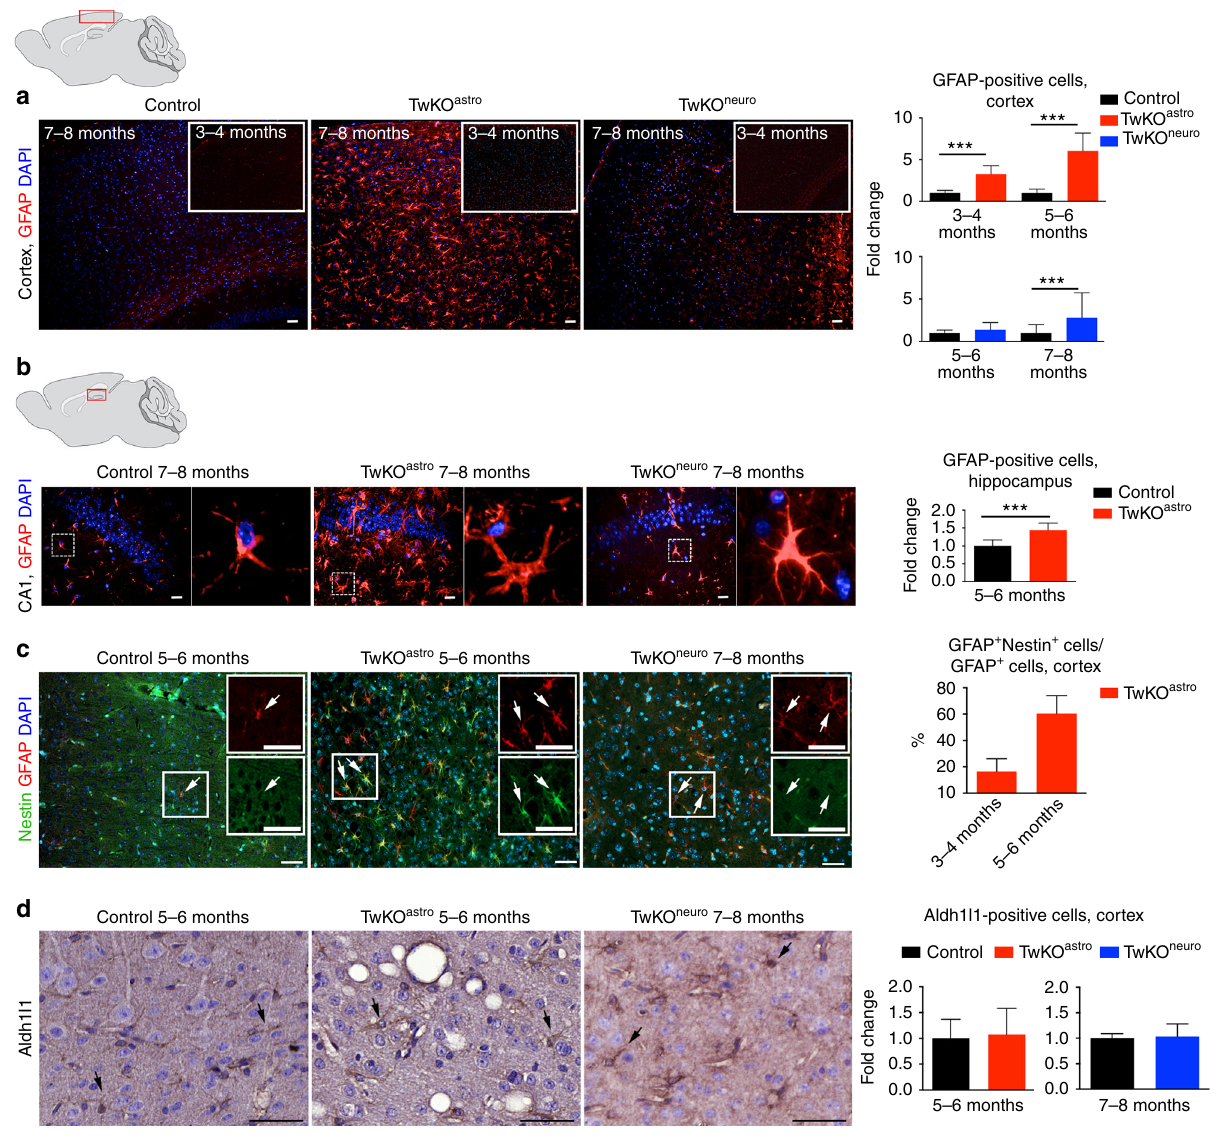
Fig. 3 MtDNA loss in astrocytes causes massive astrocyte activation. a , b Astrocytes (GFAP, red) in somatosensory cortex ( a ) and in hippocampus, CA1 area ( b ) of 7 – 8-month-old mice and 3 – 4 months as shown in inset of ( a ). In b , boxed area is enlarged on right. c Astrocytes (GFAP, red) immuno-co- stained with reactive astrocyte marker (Nestin, green). Insets enlarge the boxed area. Arrows show the same cells. d Astrocytic marker Aldh1l1 immunohistochemistry, counterstaining hematoxylin. TwKO astro show intensive vacuolization. Brain graphs show sampling site. Fluorescence fi gures are counterstained with DAPI (blue). Bar graphs on right hand side: corresponding quanti fi cations of GFAP + cells (cortex and hippocampus); GFAP + Nestin + /GFAP + , and Aldh1l1-positive cells in somatosensory cortex. The data are presented as mean and error bars indicate standard deviation. Statistical signi fi cance: * p < 0.05, ** p < 0.01, *** p < 0.001. Scale bars: 20 μ m ( a ), 50 μ m ( b – d TwKO neuro brains was unremarkable (Fig. 1i). No speci fi c